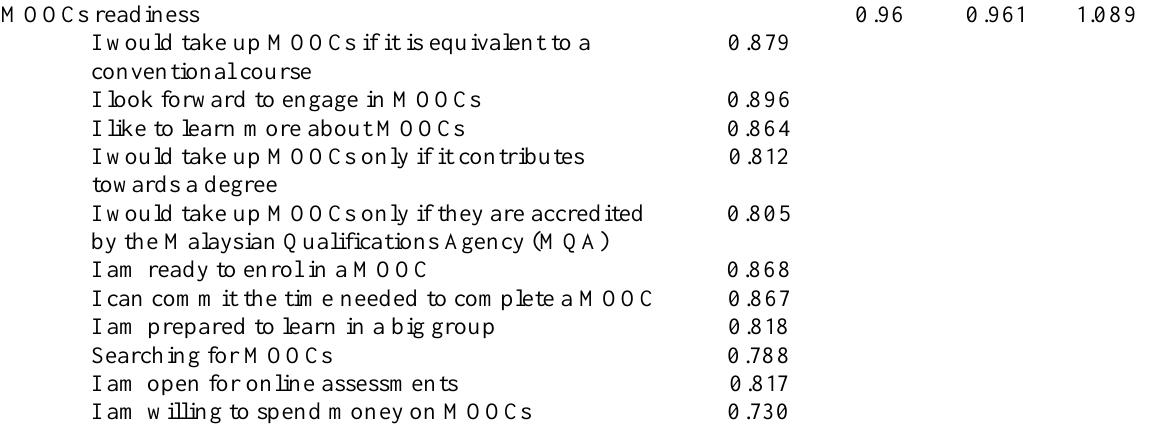
Table 9 shows that the number of distinct sample moments is 630. Number of distinct parameters to be estimated is 80 and degree of freedom (630-80) is 550. These suggest that the model studied is an over- identified model. The χ 2 -to-df ratio is less than 5. Alternative measure of fit is used instead of Chi-square. Absolute fit indices in Table 10 shows goodness of fit, GFI = 0.819, root mean square residual, RMR = 0.021, root mean square error of approximation, RMSEA = 0.064, and comparative fit index, CFI = 0.921. RMR, RMSEA, and CFI values indicate that a good fit was found for the model proposed in the study.